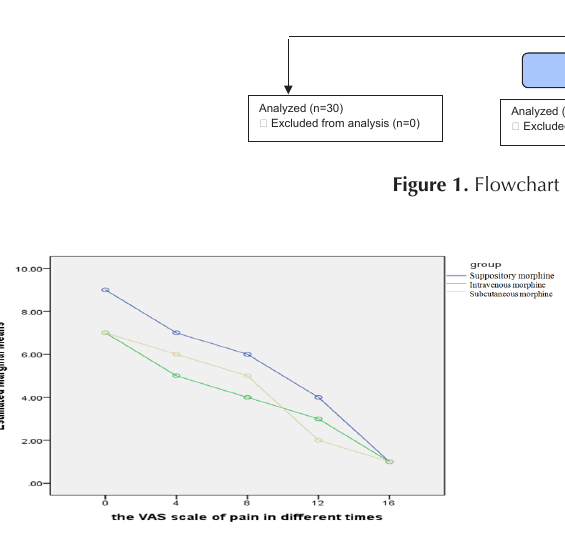
Figure 2. Pain intensity at different intervals in the studied groups based on the visual analogue